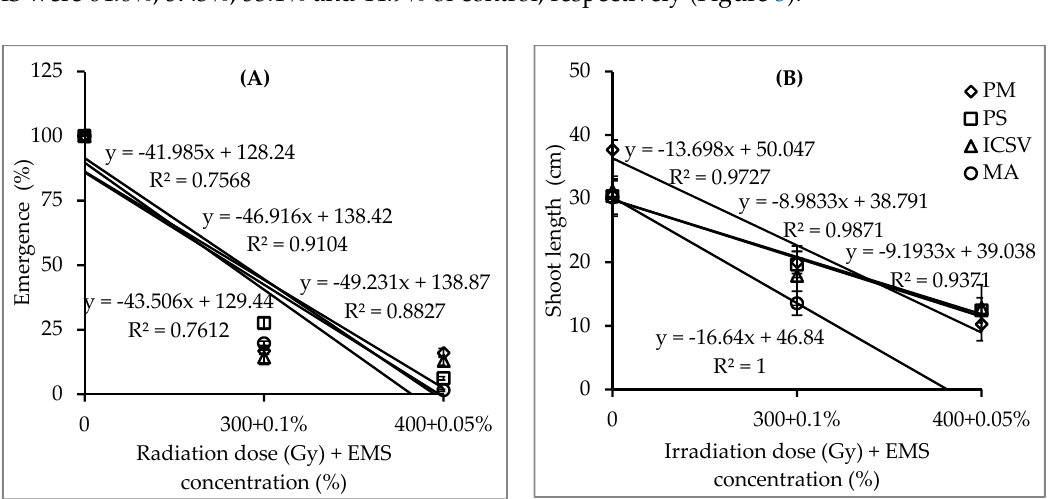
Figure 3. Emergence percentage ( A ) and shoot length ( B ) and fitted straight lines of four sorghum genotypes treated with three sequential combined treatments of gamma followed by EMS in experiment I (bars represent standard error). Note: PM = Parbhani Moti, PS = Parbhani Shakti, ICSV = ICSV 15013 and MA = Macia